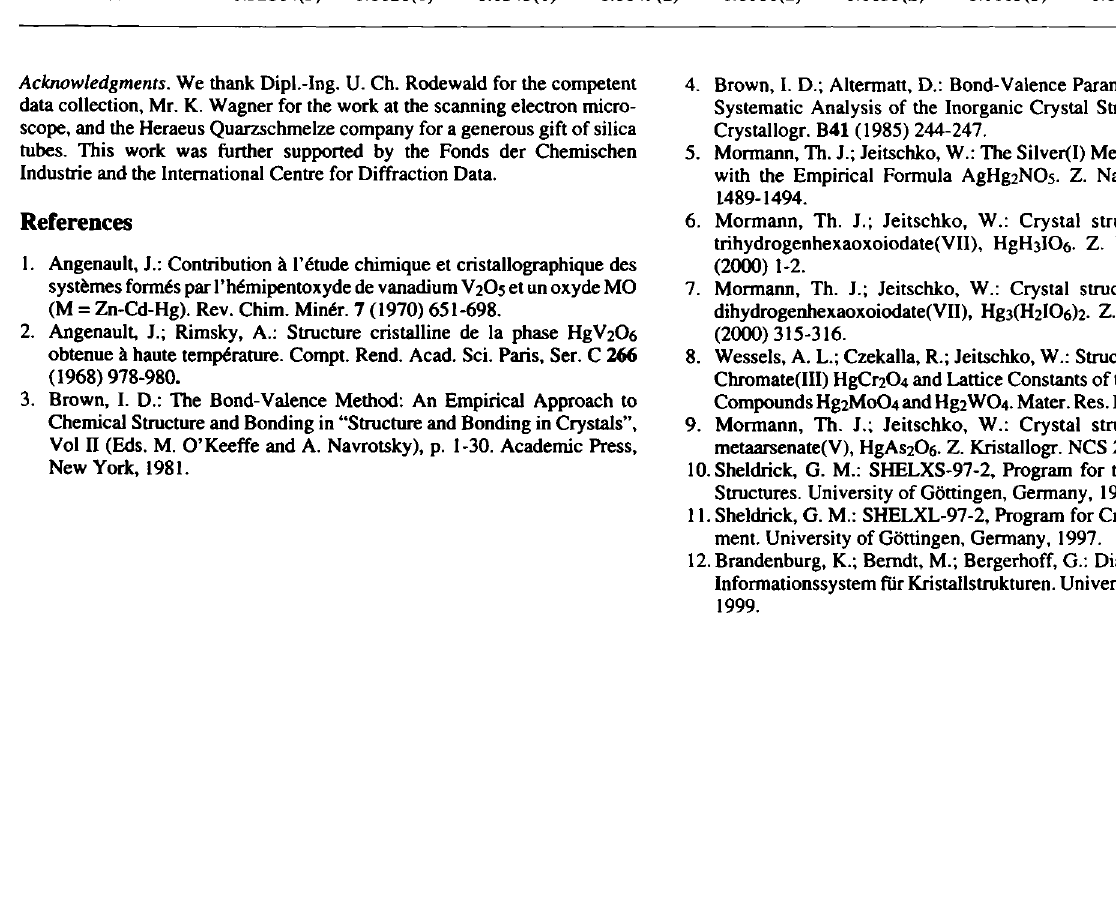
Table 3. Atomic coordinates and displacement parameters (in Ä 2 ). Atom